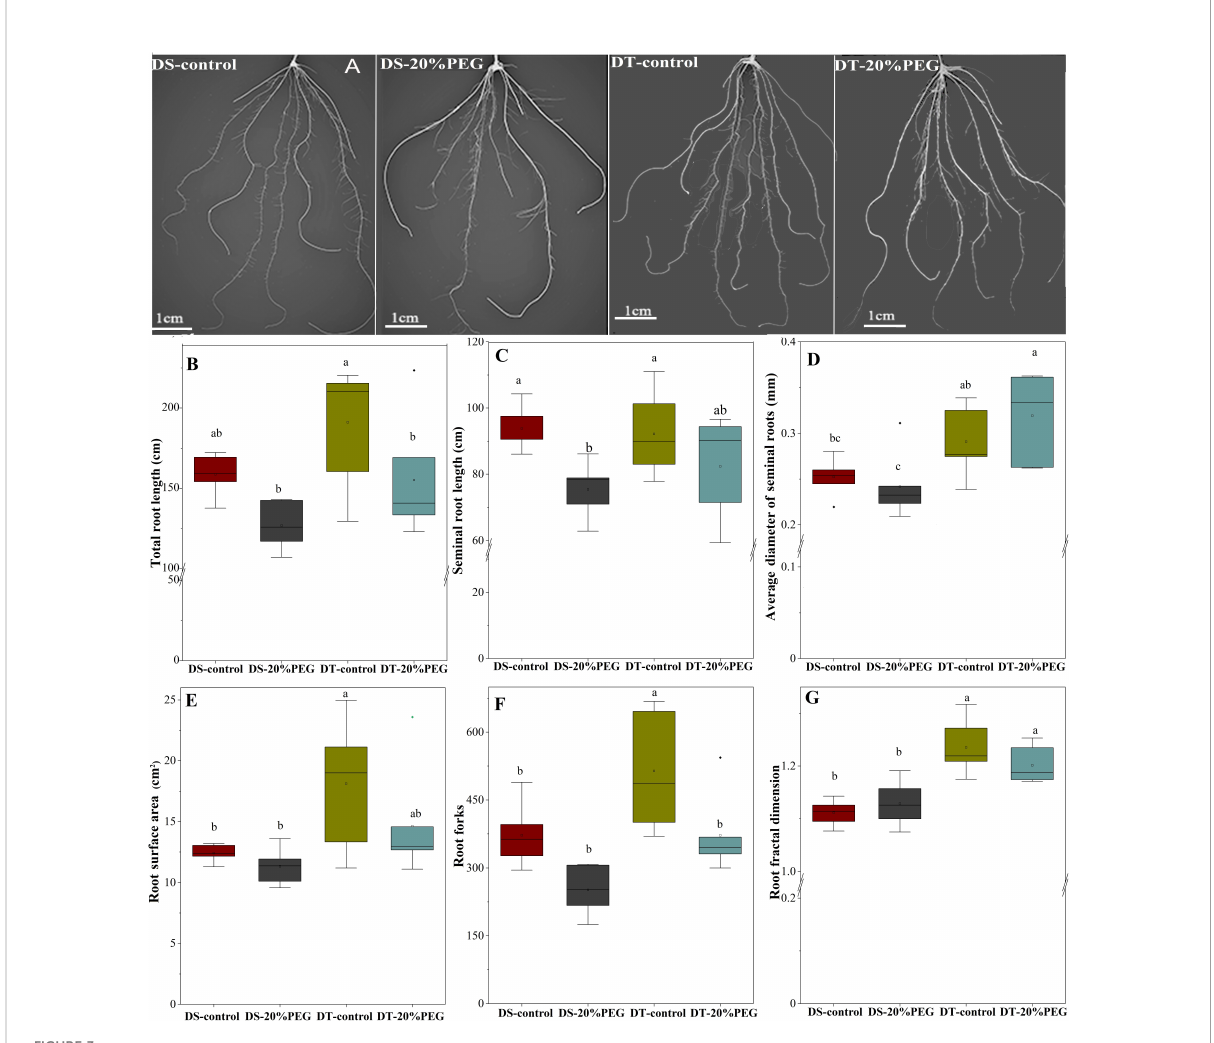
FIGURE 3 Root morphology and architecture of drought-tolerant (DT) and drought-sensitive (DS) genotypes grown under control or osmotic stress conditions. (A) Root images. (B) Total root length. (C) Seminal root length. (D) Average diameter of seminal roots. (E) Root surface area. (F) Root forks. (G) Root fractal dimension. All values represent the roots of each plant and are shown as mean with standard deviation (SD) of fi ve independent replicates (n = 5). Different letters indicate signi fi cant differences at P < 0.05 based on one-way analysis of variance (ANOVA) (Fisher ’ s Duncan